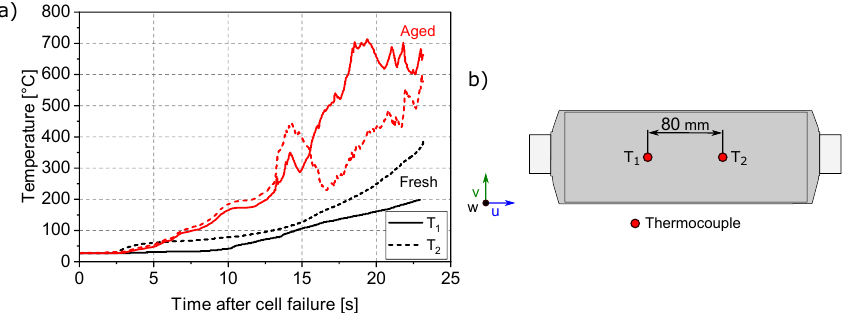
Figure 7. ( a ) Comparison of temperature increase after ISC for fresh and aged lithium-ion cells at 100% SOC under cylindrical indentation, where t = 0s represents the moment of cell failure leading to ISC. ( b ) Position of the thermocouples type K installed on the cell for temperature